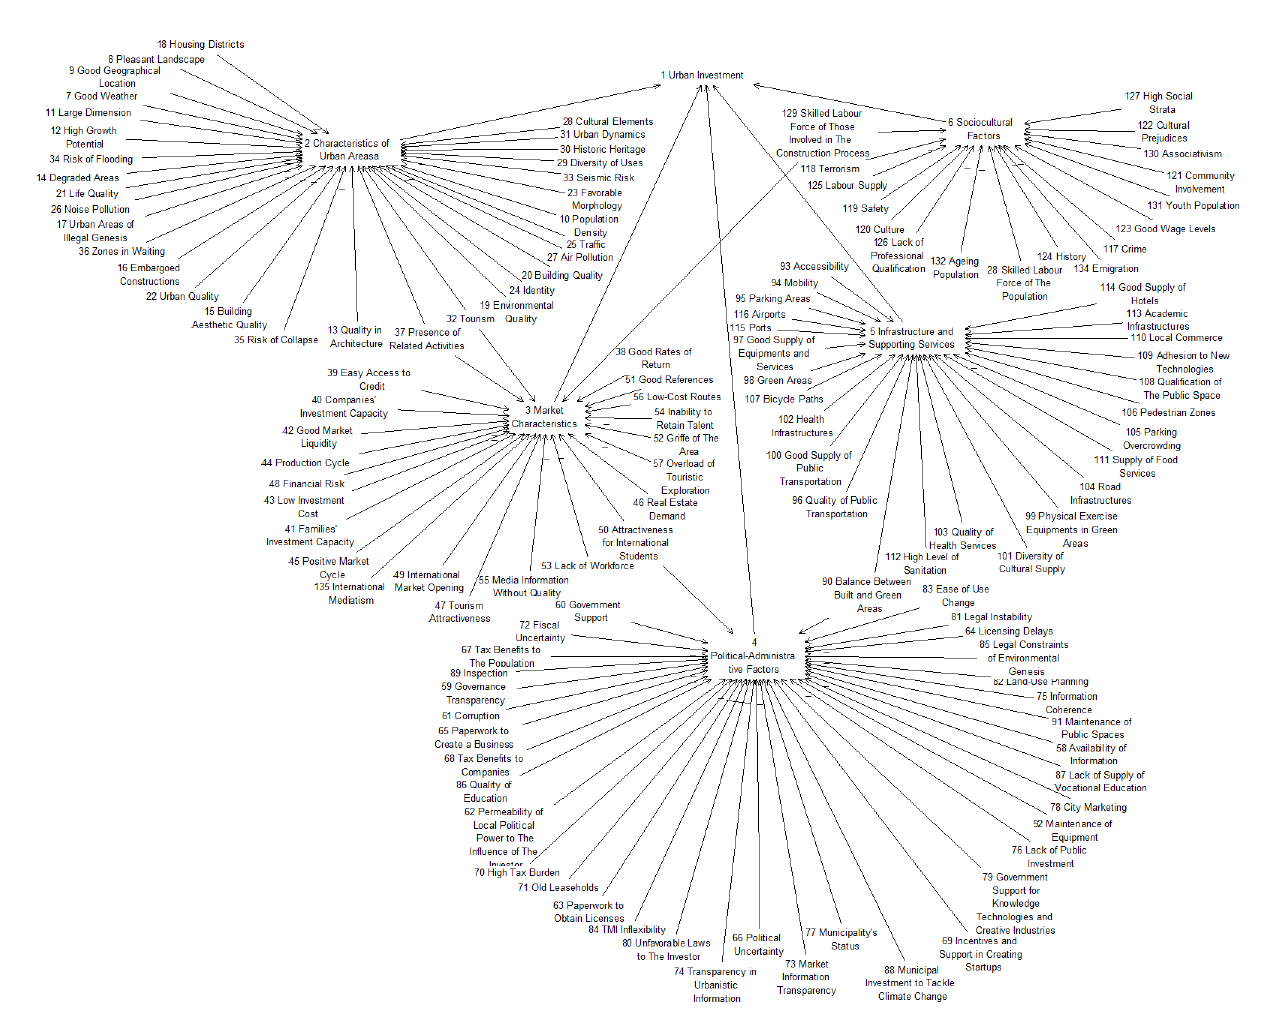
Figure 4. Collective cognitive